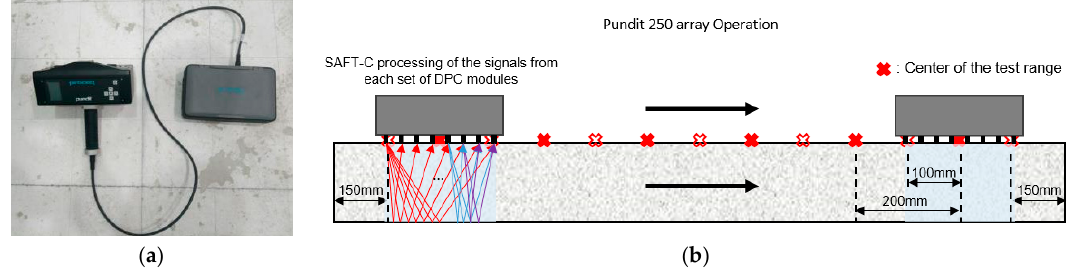
Figure 3. Shear wave tomography test method. ( a ) Tomography equipment; ( b ) Procedure of S-wave measurement.